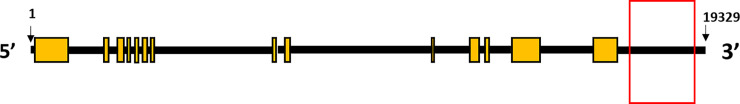
Illustration of DNA and mRNA of Elaeis guineensis’s whole ThiC gene depicting the exon (red) and intron (grey) regions.The putative TPP riboswitch was detected at the non-coding region of 15th intron nearly at the 3’ end of the mRNA sequence.